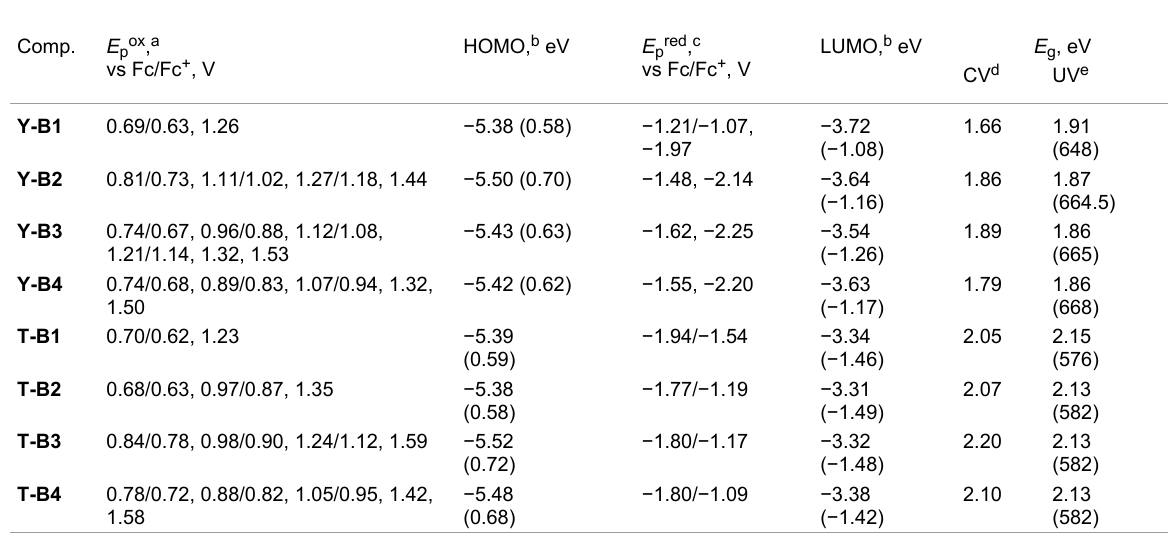
Table 2: Electrochemical data for oligofluorene–BODIPY compounds and HOMO–LUMO gaps calculated from cyclic voltammetry and electronic absorption spectroscopy. Comp.